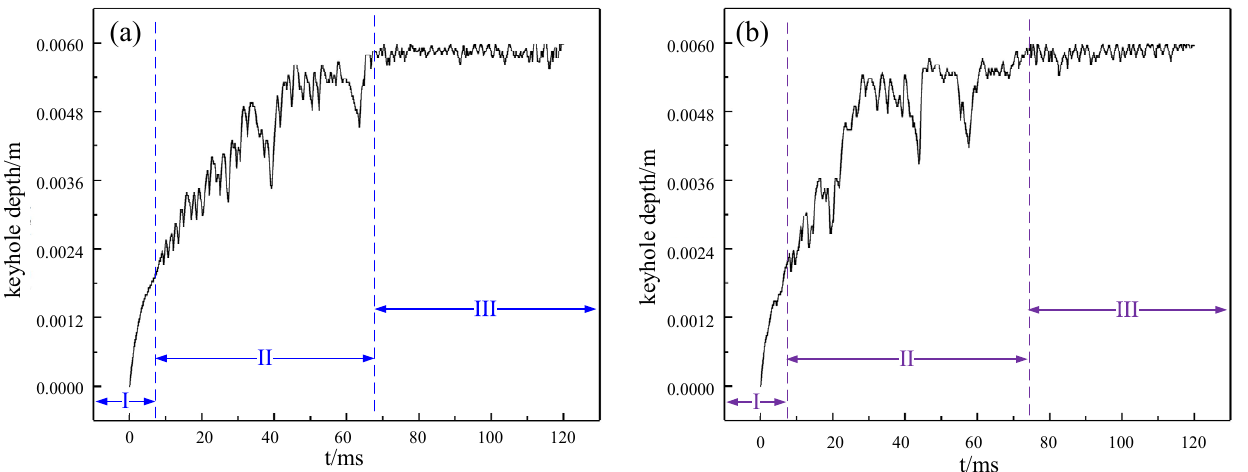
Figure 9. Keyhole depth fluctuation under different arc currents. ( a ) I = 90 A; ( b ) I = 100 A.